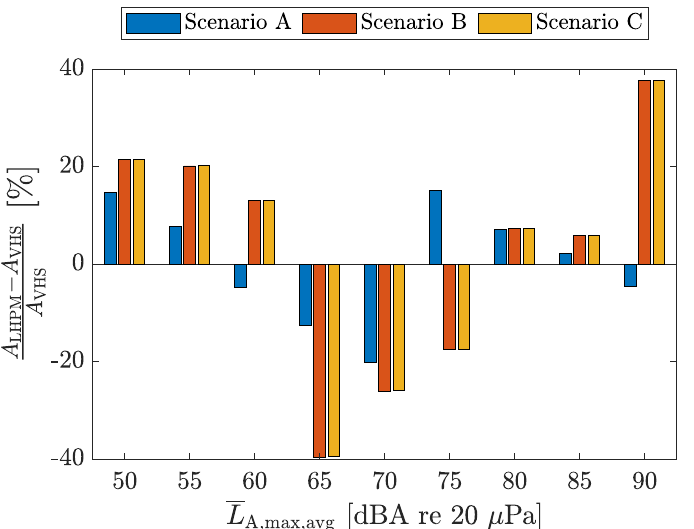
Figure 9. L A,max,avg noise contours for the vertical holding stack (upper row) and the linear hold point merge (lower row): ( a , d ) Scenario A, ( b , e ) Scenario B, ( c , f ) Scenario C. Inset figures show the noise contours close to the runway. For the sake of clarity, only flight trajectories calculated based on the performance of the Airbus A320 are presented.